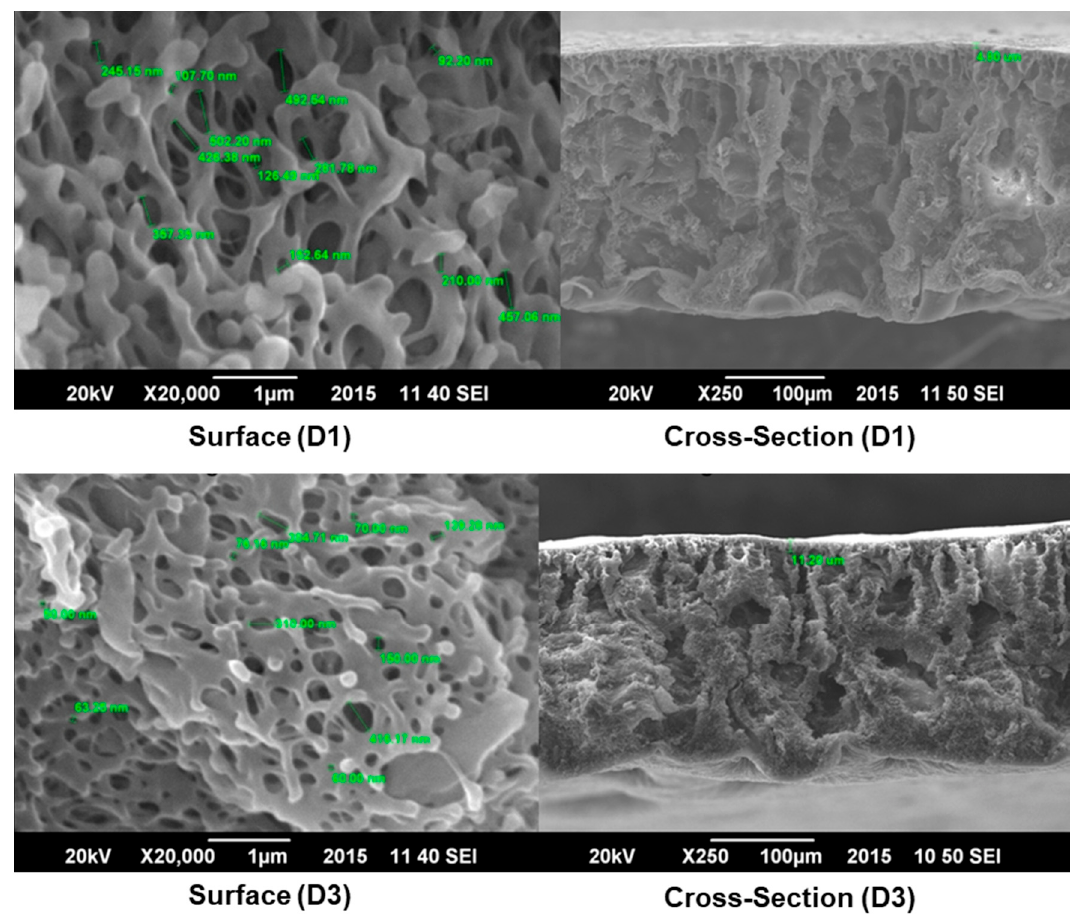
Figure 3. SEM images of surface and cross ‐ section of DMSO ‐ based membranes (D1 and D3).